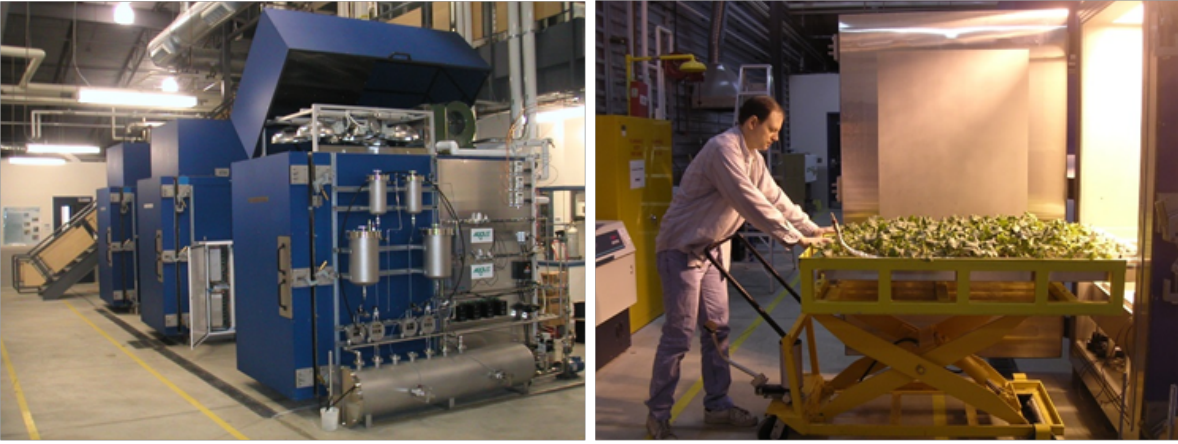
Figure. 7. Hypobaric plant test chamber plant test chambers located at the University of Guelph, Ontario, Canada (left). Dr. Mike Staskiak (right) of the University of Guelph removing trays of radishes grown at 33 kPa total pressure. Photos courtesy of Dr. Tom Graham, University of